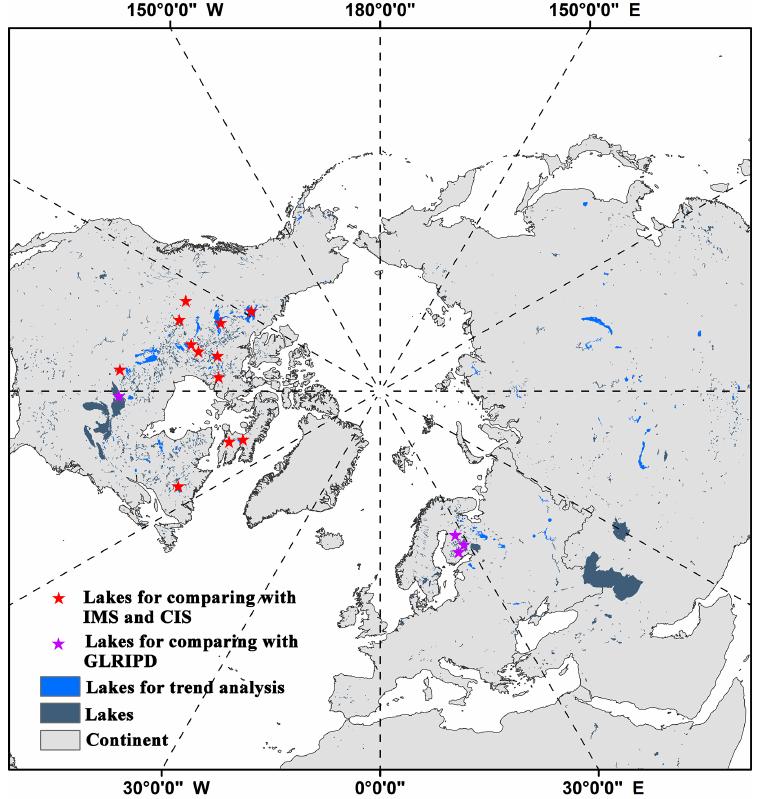
Figure 1. Three sets of lakes selected for the LIP analysis in the Northern Hemisphere mid- and high latitudes ( ≥ 30 ◦ N). The purple star symbols denote lakes used for evaluating LIP retrievals on a per pixel basis against GLRIPD ground-based observations, including Lake Superior in the USA and Canada and Lake Oulujarvi, Lake Haukivesi, and Lake Paijanne in Finland. The red star symbols denote 12 lakes (Great Bear Lake, Great Slave Lake, Smallwood Lake, Nettiling Lake, Dubawnt Lake, Amadjuak Lake, Wollaston Lake, Baker Lake, Kasba Lake, Lesser Slave Lake, and Peter Pond Lake in Canada and Red Lake in USA) used for the lake-wide comparisons between the LIP results from this study and other regional lake ice phenology records (IMS, CIS). The 71 lakes selected for assessing LIP trends over the 12-year satellite record are in bright